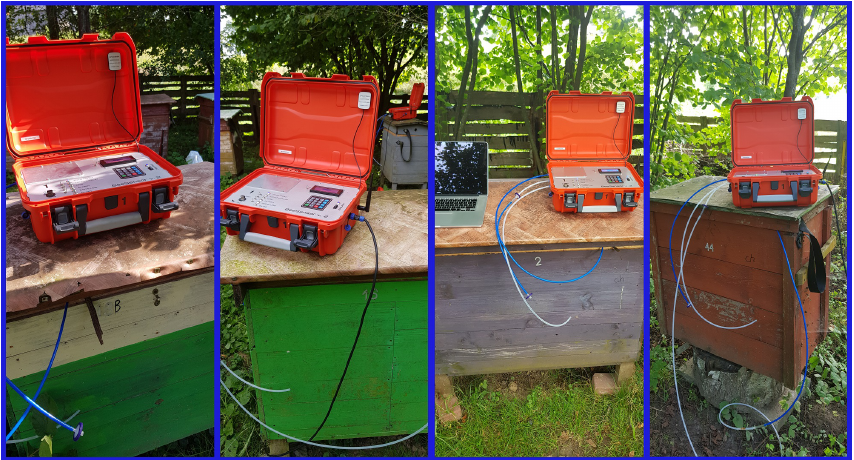
Figure 3. Multi-sensor recorder Beesensor V.2, unit BEECOM 1, during the measurement session of the different bee colonies.